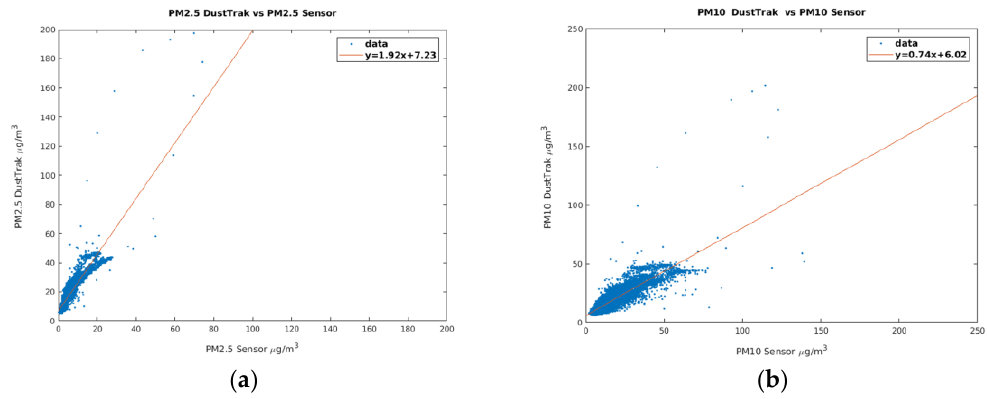
Figure 6. Scatter-plots of 2-min sampled sensor signals vs. reference signals observed during sensors calibration: ( a ) PM 2.5 ; ( b ) PM 10 .